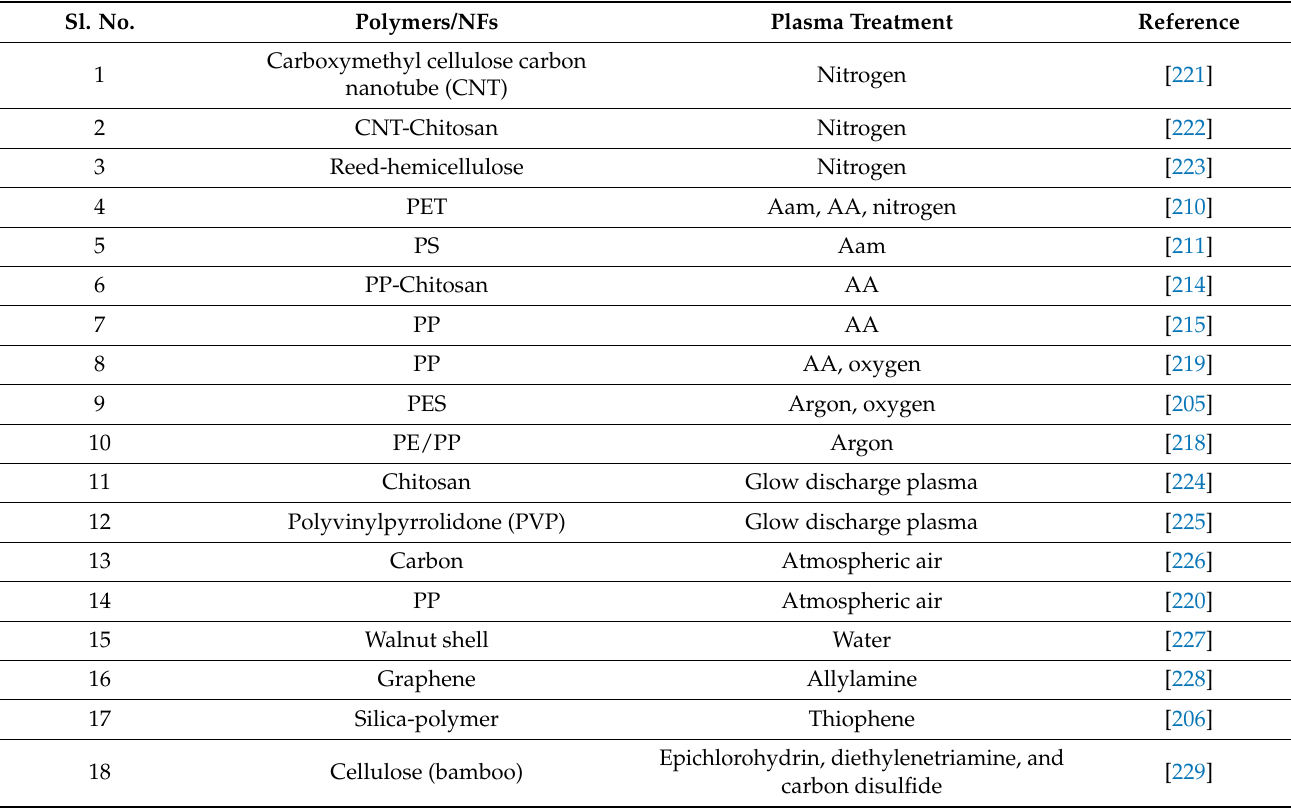
Table 4. Reported some studies of plasma-treated polymers for HM